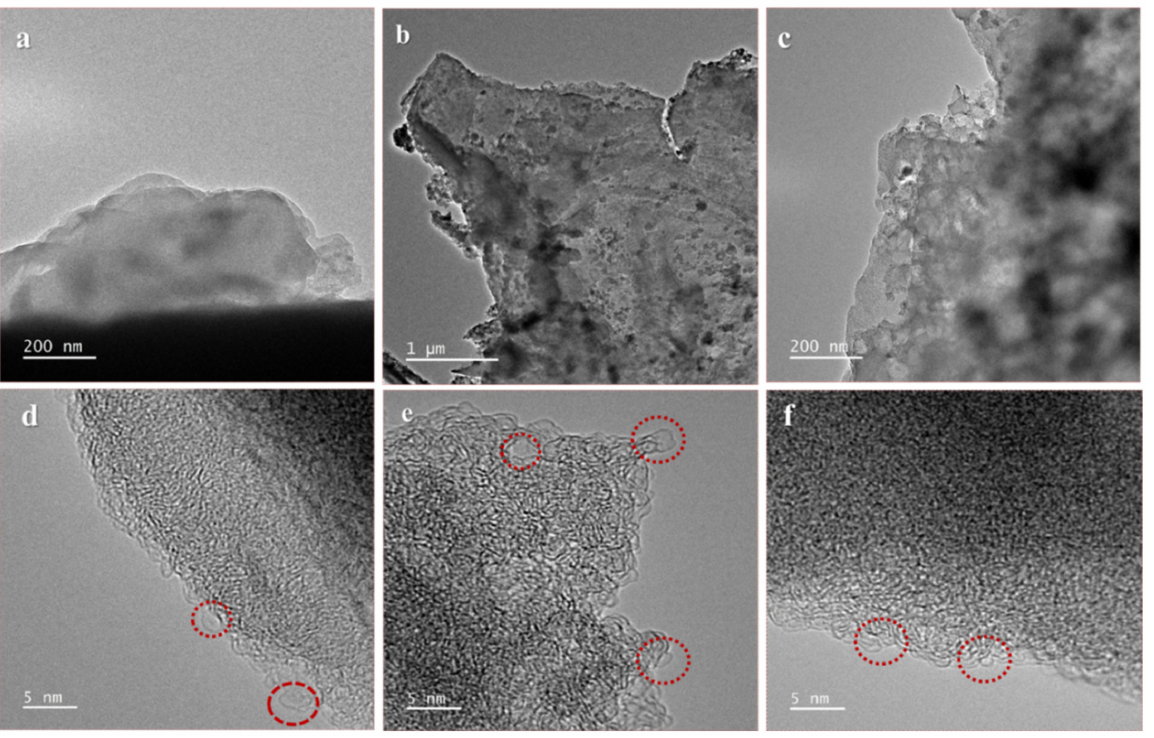
Figure 2. TEM and HR-TEM images of ( a , d ) GTPC-0, ( b , e ) GTPC-1, and ( c , f ) GTPC-KOH. The XRD patterns of the GTPC samples are shown in Figure S1. The wide-angle XRD patterns showed two evident diffraction peaks at 25 ◦ and 44 ◦ , corresponding to the (002) and (110) planes of the carbon, respectively [22]. The presence of these broad